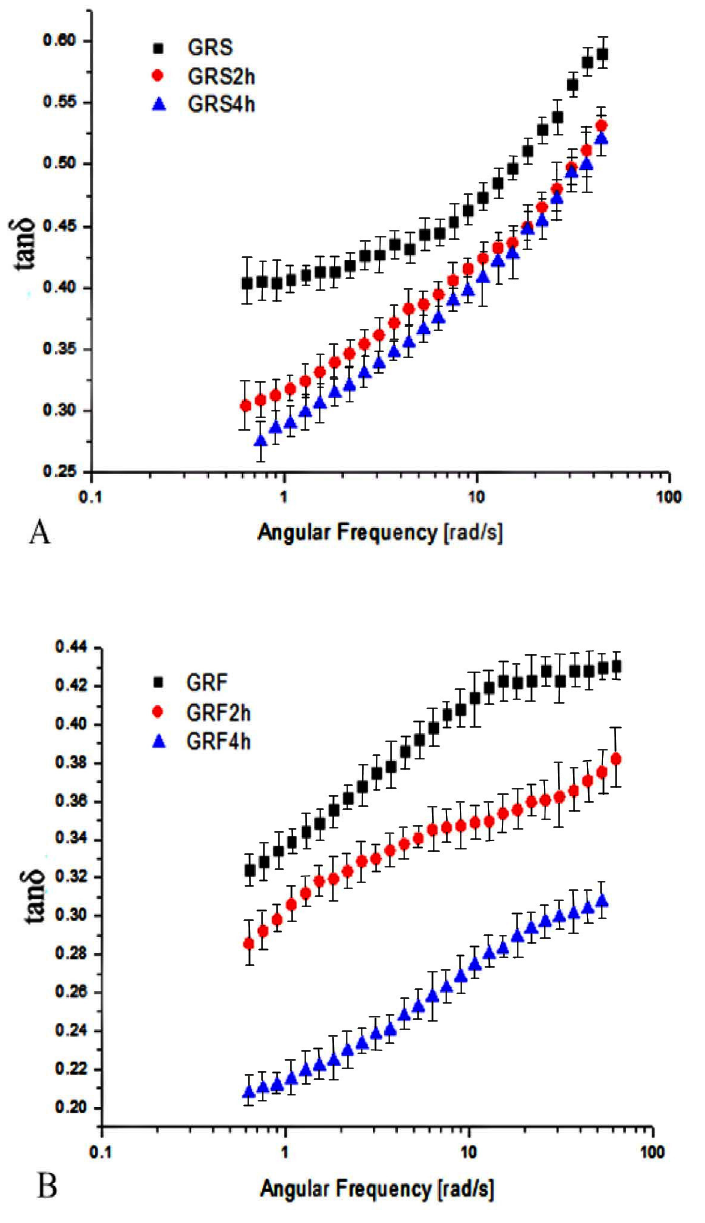
Fig 5. Loss tangent (tan δ = G"/G') as a function of angular frequency for the GRS (A) and GRF (B) before and after dry heating. GRS2 h, 4 h: the glutinous rice starch (GRS) pastes after dry-heat treatment at 130°C for 2, 4 h; GRF2 h, 4 h: the glutinous rice flour (GRF) pastes after dry-heat treatment at 130°C for 2, 4 h. The data points represent the mean values of three samples and error bars show the standard